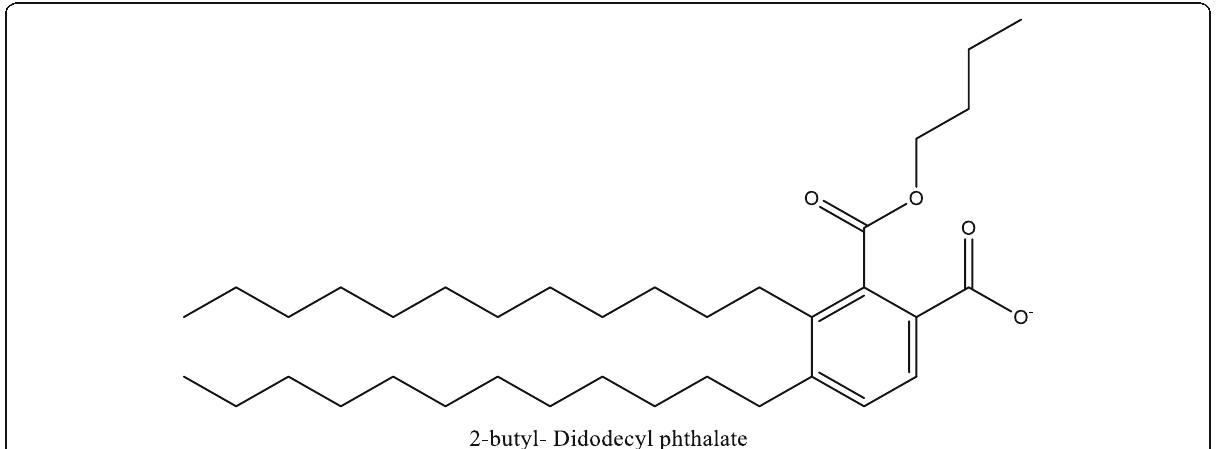
Fig. 9 Chemical structure of an ester isolated from A.